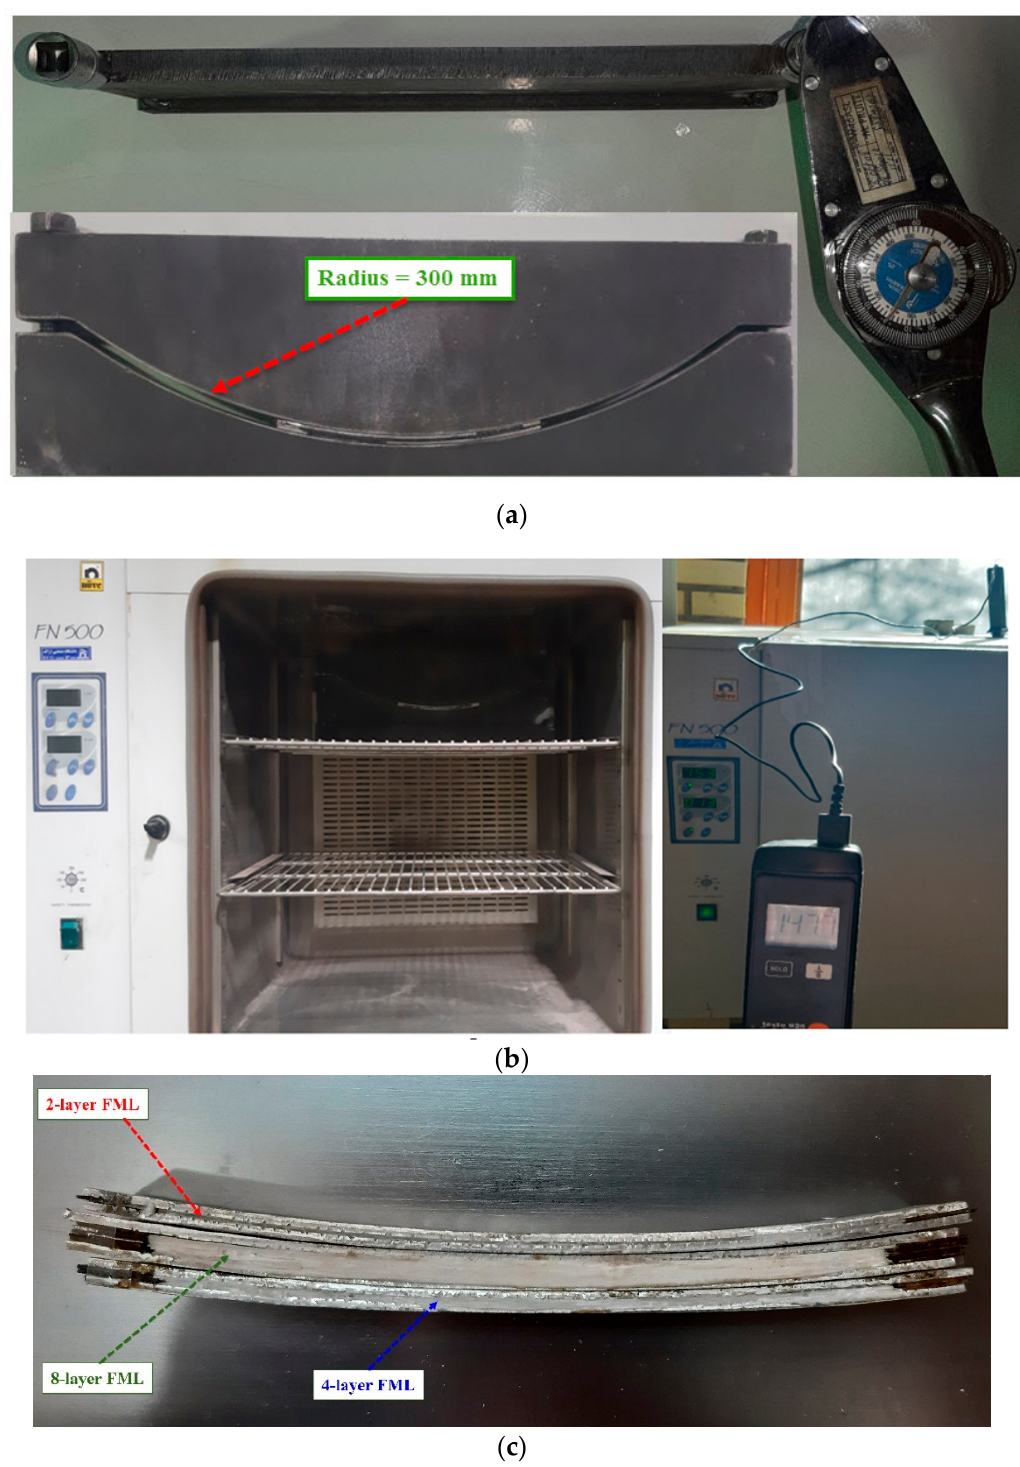
Figure 3. ( a ) A FML that is placed between die components with torque meter, ( b ) The entire assembly in the furnace, ( c ) Some creep age formed FMLs.